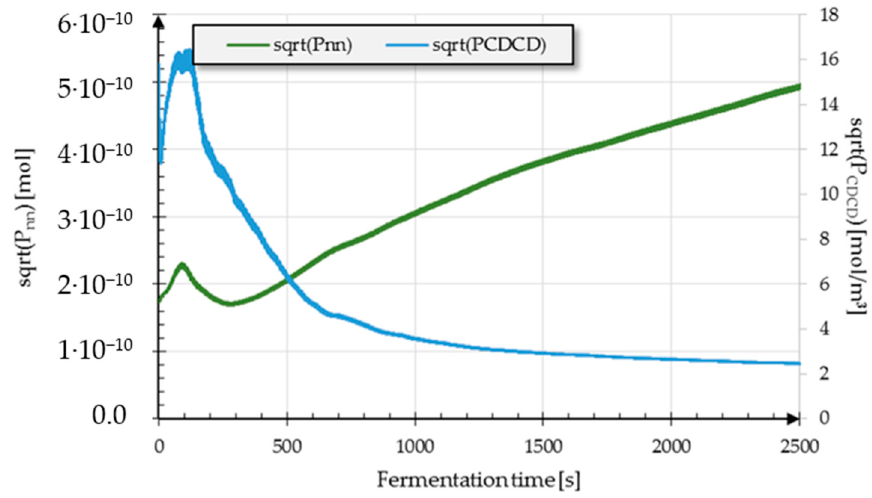
Figure 6. Estimation error of the CO 2 in non-gaseous dough and the amount of CO 2 in the bubble.